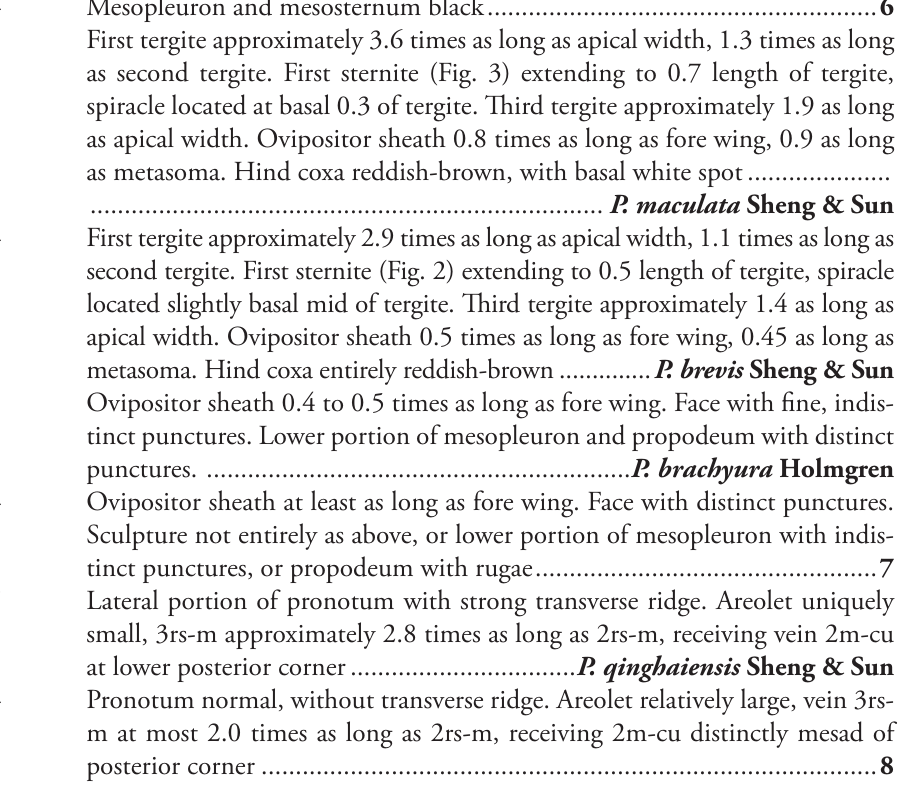
– Face with dense punctures. First tergite 3.0 times as long as apical width. Third tergite as long as second tergite. Hind tarsomeres entirely black ..........